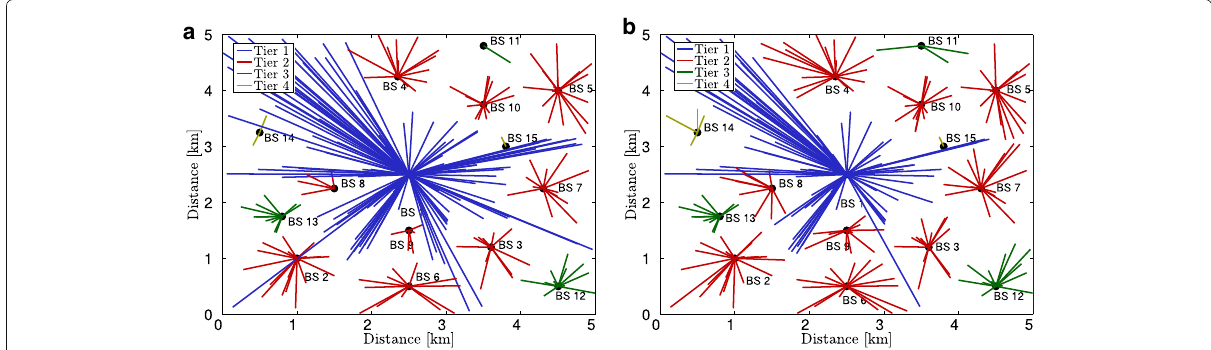
Fig. 4 Snapshot of the user association for different policies. a User association policy: max-SINR. b User association policy: problem